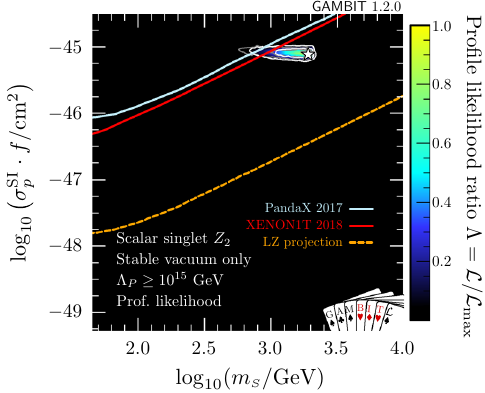
Fig. 7 AsinFig.3,butwiththeaddedrequirementsofvacuumstability and perturbativity to large scales, Λ P > 10 15